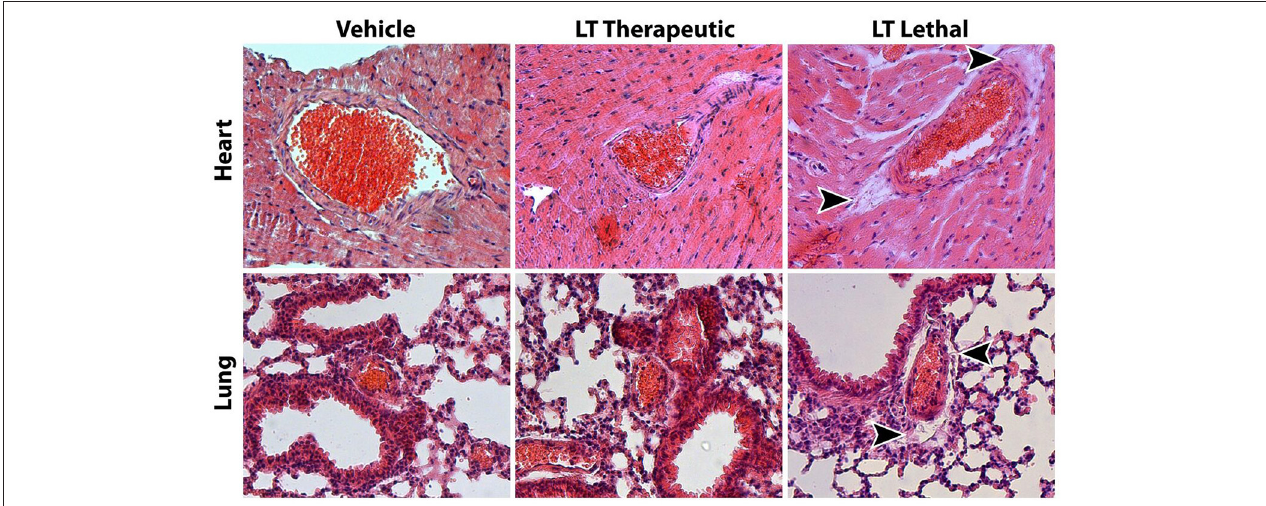
FIGURE 1 | Assessment of Clostridium sordellii lethal toxin (LT) toxicity. The main characteristic of LT toxicity is increased vascular permeability with perivascular edema. Representative HE stainings of heart and lung tissue from mice treated with vehicle or a therapeutic dose of LT for 4 weeks show no signs of tissue edema. In contrast, mice that received a lethal dose of LT display edema in the connective tissue surrounding larger arteries (arrow heads).